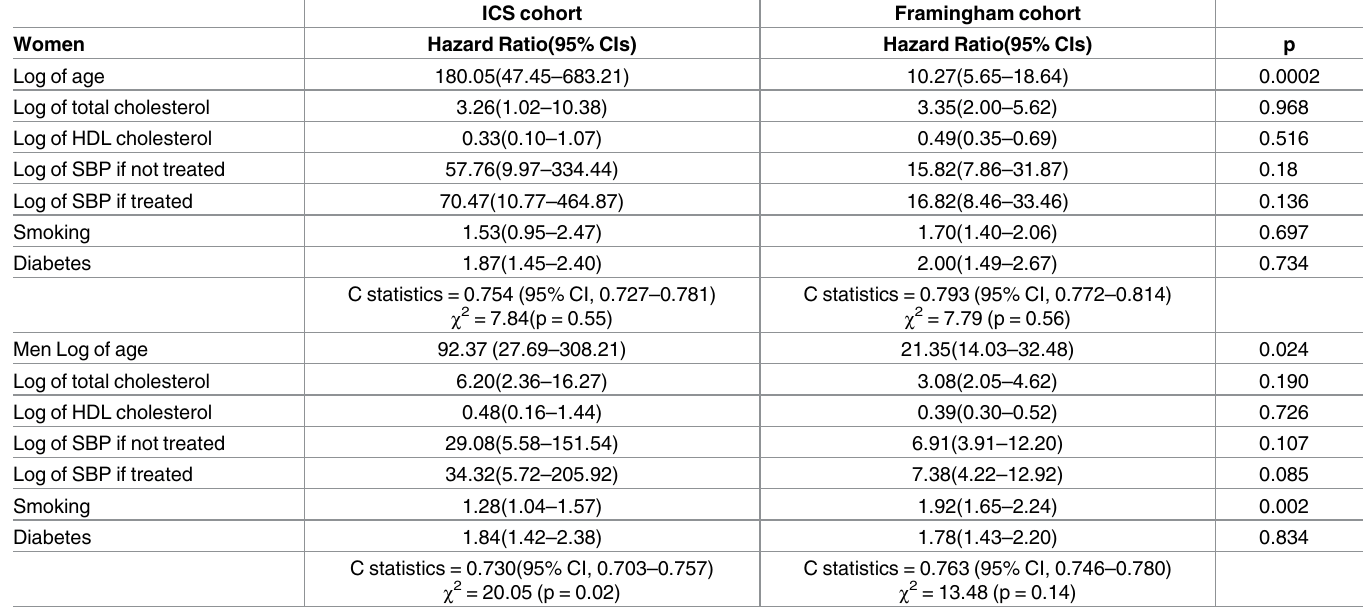
Table 3. Comparison of relative risk and performance of ICS and